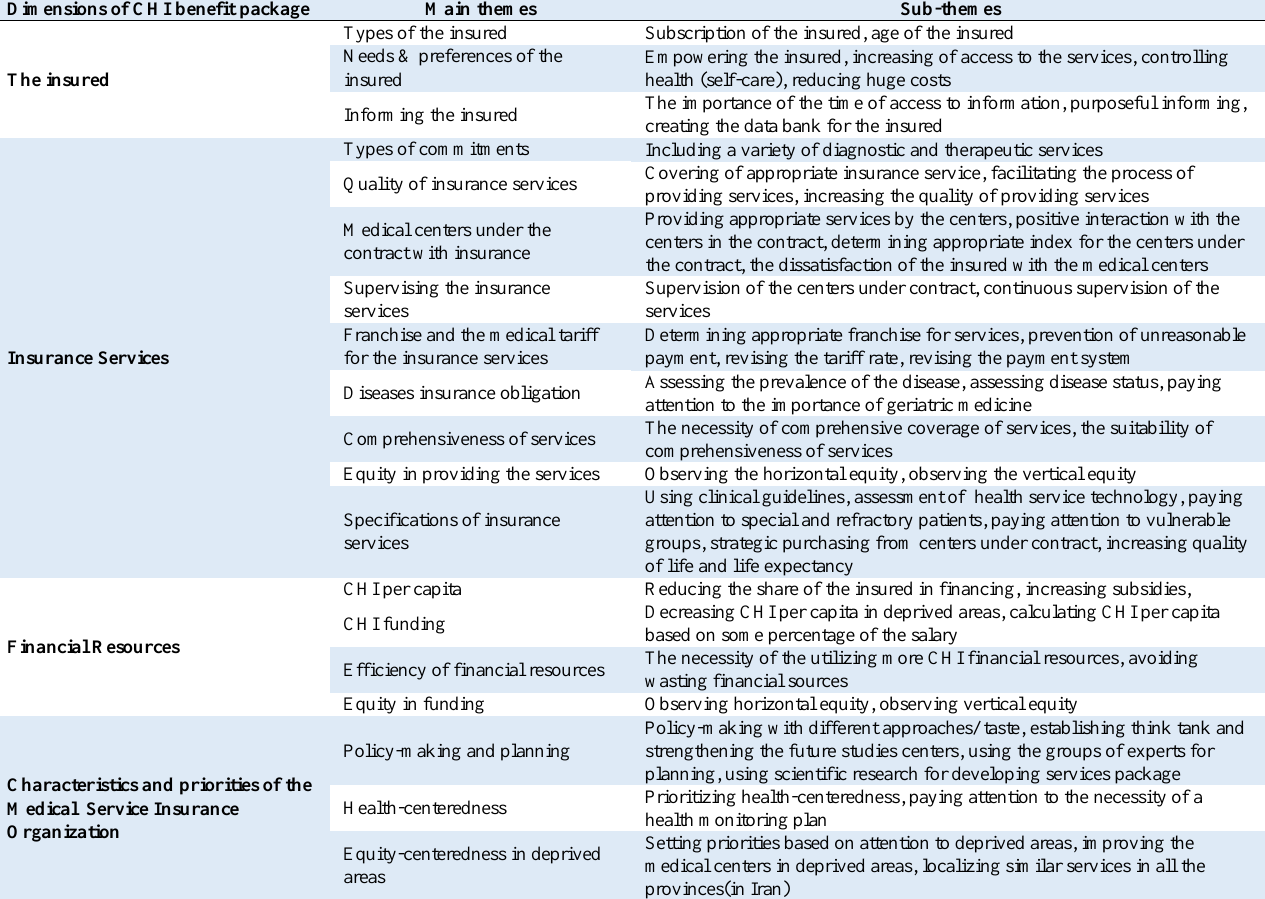
Table 1. Effective main themes and sub-themes in developing CHI benefit packages Dimensions of CHI benefit